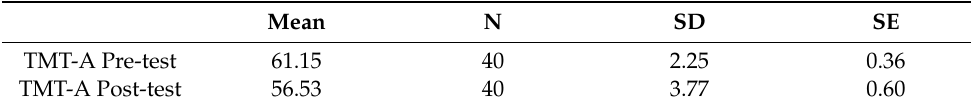
Table 13. Paired samples statistics of TMT-A.